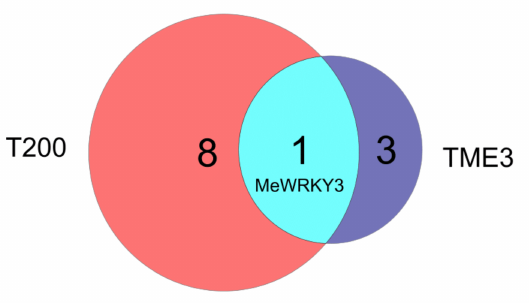
Figure 2. Total number of all MeWRKY transcription factors differentially expressed in TME3 and